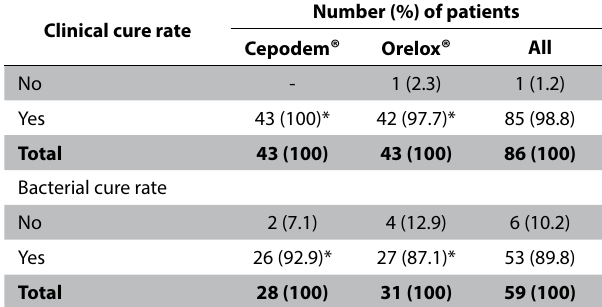
Table III. Clinical and bacteriological cure rates* Clinical cure rate